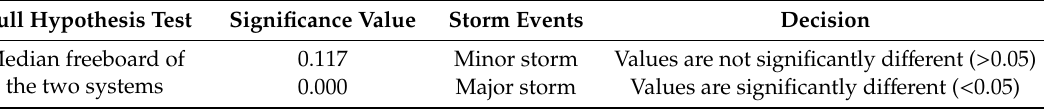
Table 3. Hypothesis test of freeboard for the two drainage systems.